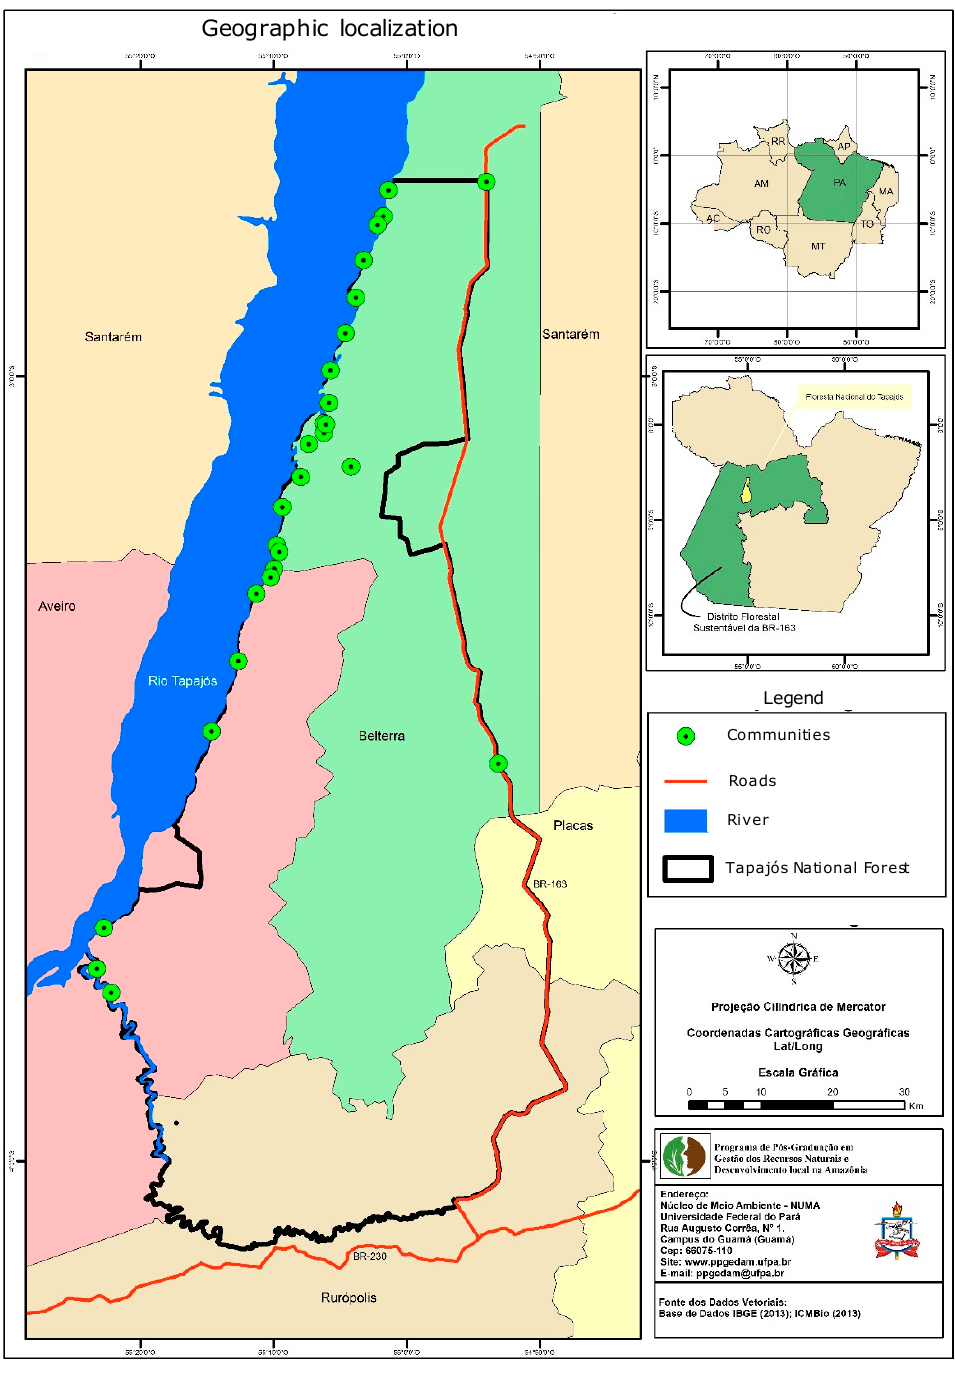
Figure 1. Tapajós National Forest is located near an interstate highway (BR-163) and distributed in the areas of four municipalities: Rurópolis, Belterra, Placas, and Aveiro.